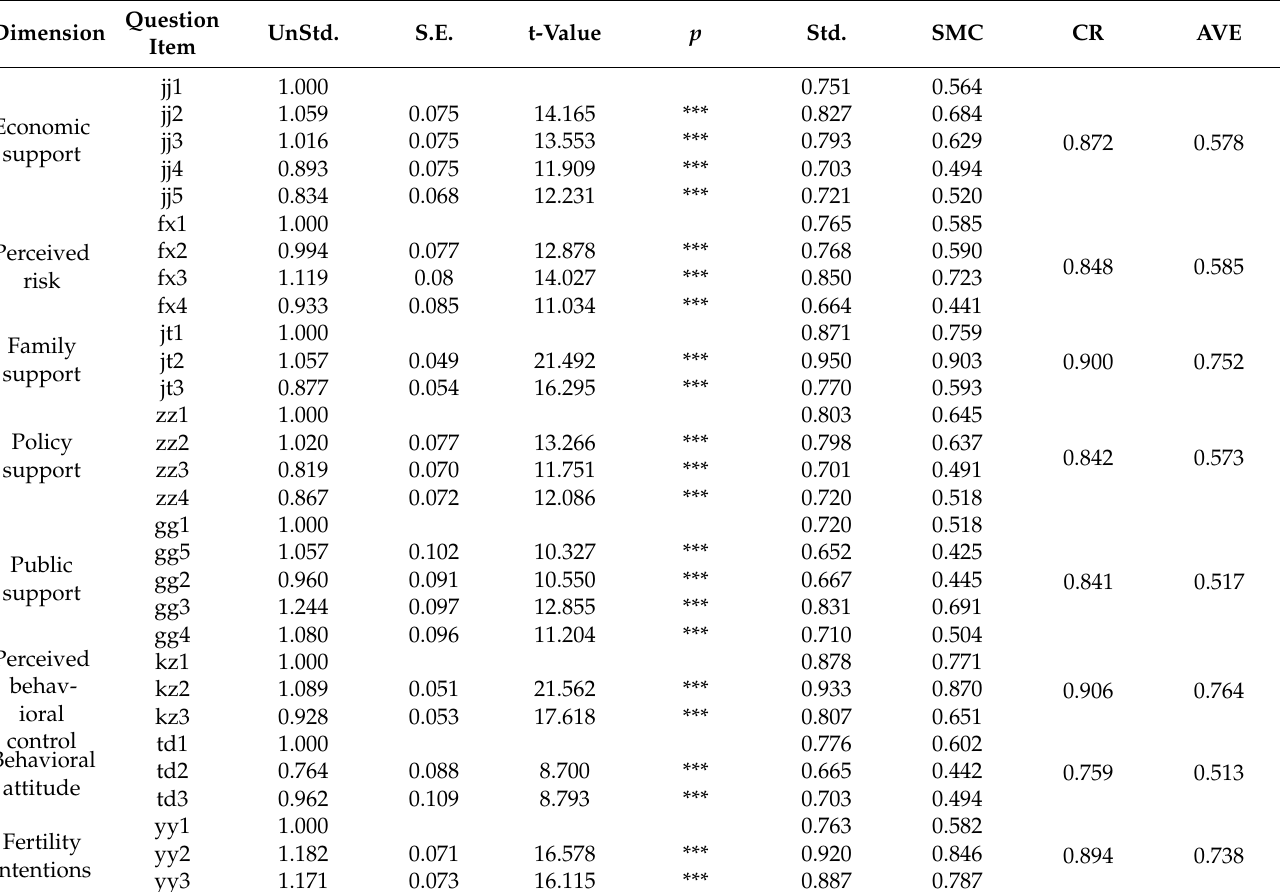
Table 6. Convergence validity test table.